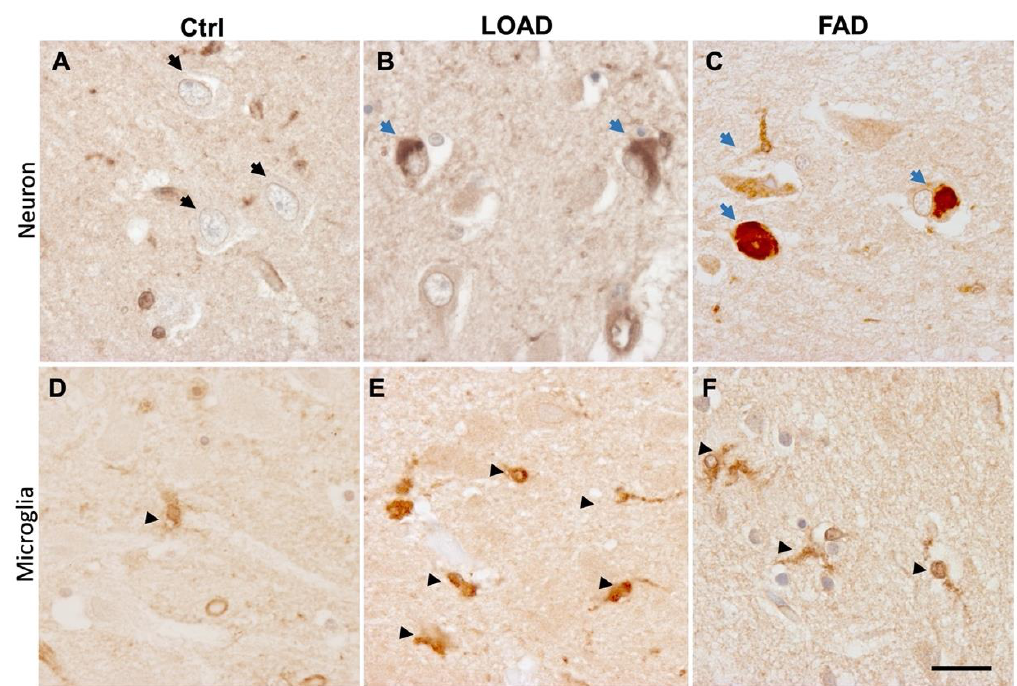
Figure 6. PICALM immunolabelling is increased in LOAD and FAD in correlation with the de- velopment of tau pathology. Representative immunolabelling of anti-PICALM antibody (Sigma #HPA019053) in the Cornu Ammonis regions of the hippocampus of control ( A , D ), LOAD ( B , E ) and FAD with PSEN1 mutations at R35E and E120D ( C , F ). In non-demented control brain, a perinuclear immunolabelling of PICALM was detected in neurons (black arrows) ( A ). A PICALM immunore- activity was detected in NFTs in neuronal perikarya (blue arrows) in the affected brain areas of LOAD ( B ) and FAD ( C ). PICALM-immunoreactive microglial cells were faintly detected in control brains (arrowheads) ( D ), and the number and the intensity of PICALM-stained microglia were increased in LOAD ( D ) (arrowheads). In FAD ( F ) brains, the increase in PICALM immunostained microglial cells was less prominent than in LOAD. More detailed data can be found in our article [33]. Control